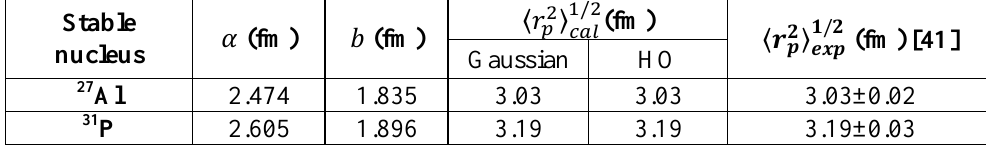
Table 2: GS and HO size parameters for the stable nuclei 27 Al and 31